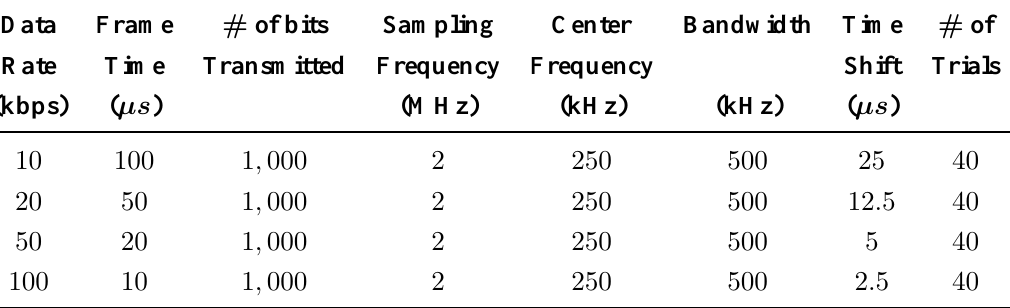
Table 1. Test parameters for TR-PPM